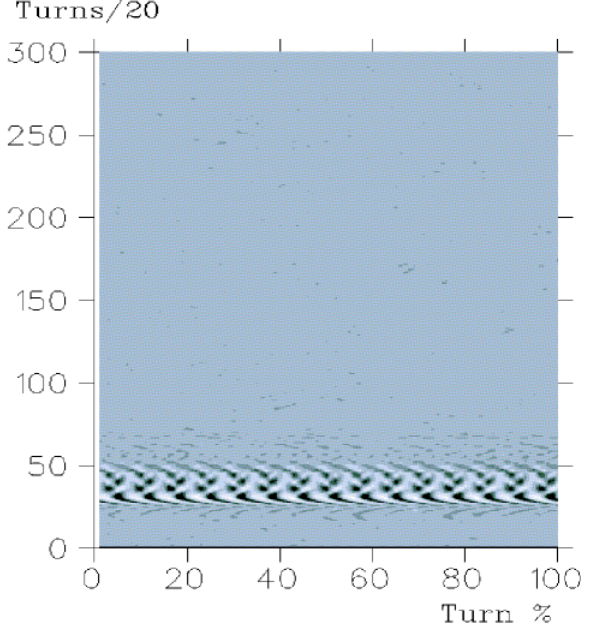
FIG. 17. Waterfall plot of line density, 6000 turns, 0 protons, 10 6